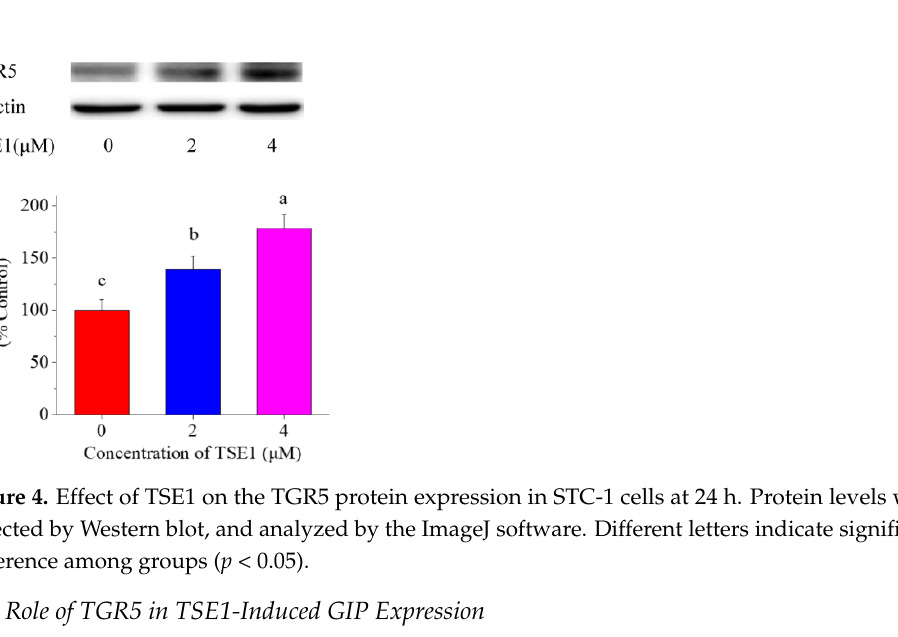
6 of 12 Figure 3. Effect of phlorizin on the Ca 2+ concentration and GIP expression in STC-1 cells at 24 h. ( A ) Cell viability after 24 h treatment of phlorizin determined by MTT assay. ( B ) The intracellular Ca 2+ concentration determined by BBcellProbe F03 assay. ( C ) The mRNA expression of GIP determined by RT-PCR. Different letters indicate significant difference among groups ( p < 0.05). * p < 0.05, ** p < 0.01, compared with normal group.